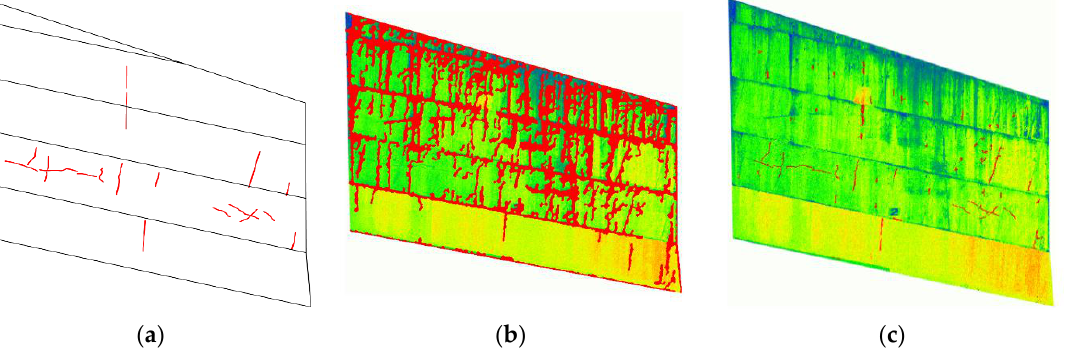
Figure 16. The comparison of the proposed method with Talab’s method and the crack maps by visual inspection. ( a ) Crack pattern map; ( b ) Talab’s method; ( c ) Proposed method.